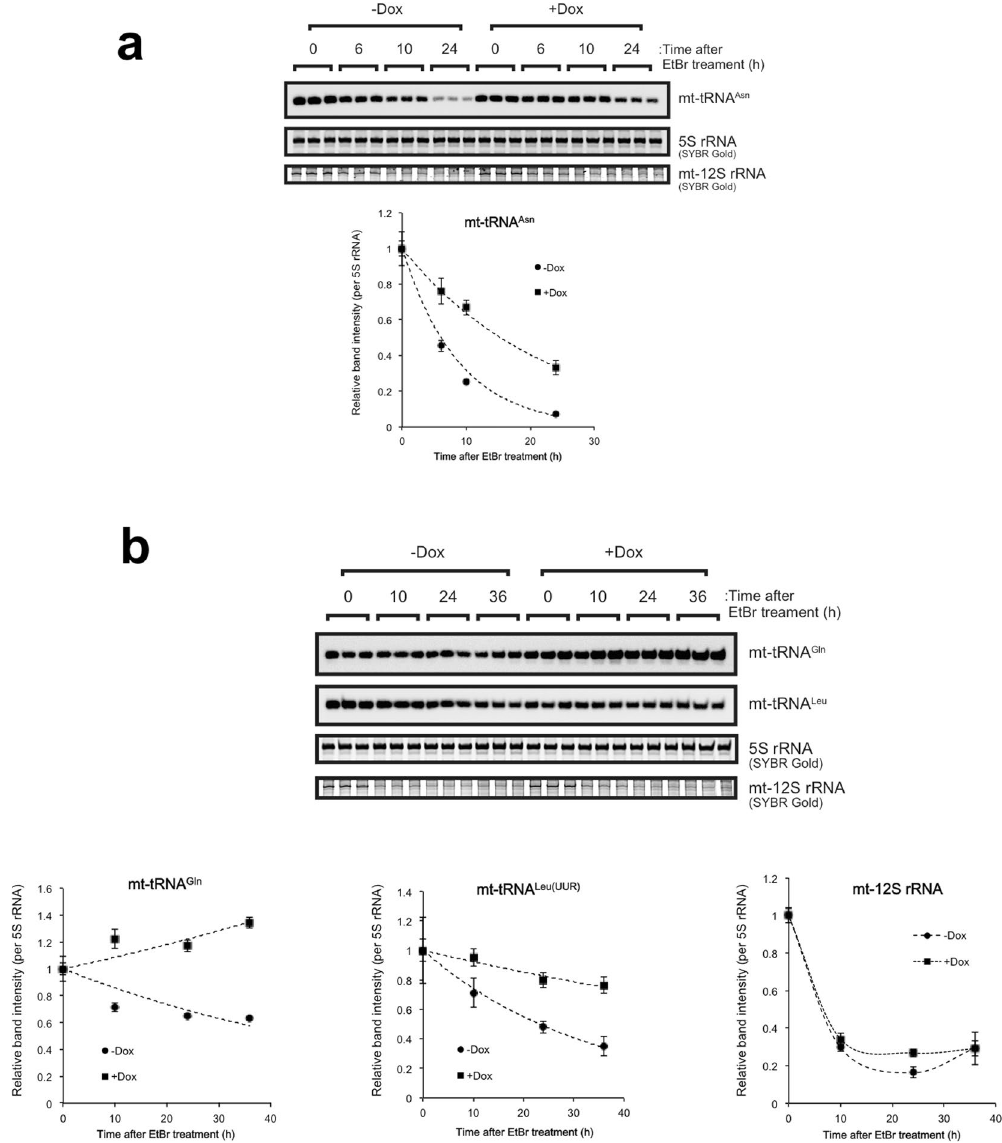
Figure 3. TDP-43 overexpressed increases stabilities of mt-tRNA Asn , mt-tRNA Gln , and mt-tRNA Leu(UUR) . DAP- TDP-43–inducible T-REx 293 cells were treated with or without doxycycline (Dox) for 24 h and then treated with EtBr for the indicated periods. Cells were collected at 0, 6, 10, and 24 h after addition of EtBr for analysis of mt-tRNA Asn by northern blotting ( a ) and at 0, 10, 24, 36 h for analysis of mt-tRNA Gln or mt-tRNA Leu(UUR) ( b ). mt-12S rRNA was detected by SYBR Gold staining and MS-based analysis ( b ). The graphs present data for the average ± SD (three independent experiments) of staining intensities at each time point relative to 0 h. Each band intensity was normalised to that of 5S rRNA detected using SYBR Gold